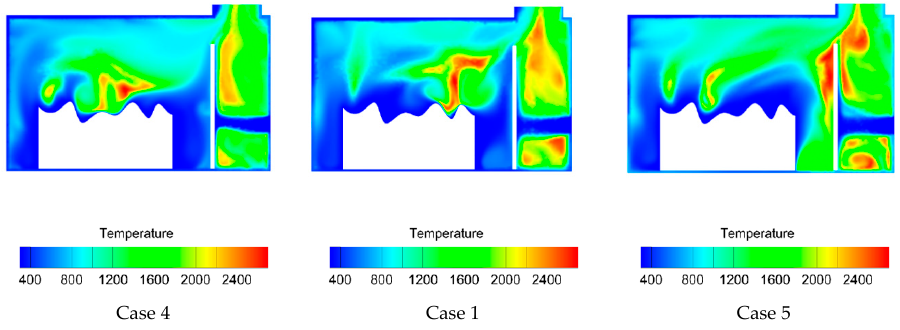
Figure 14. Temperature contours inside the incinerator for the place of installation of the primary burner (K).